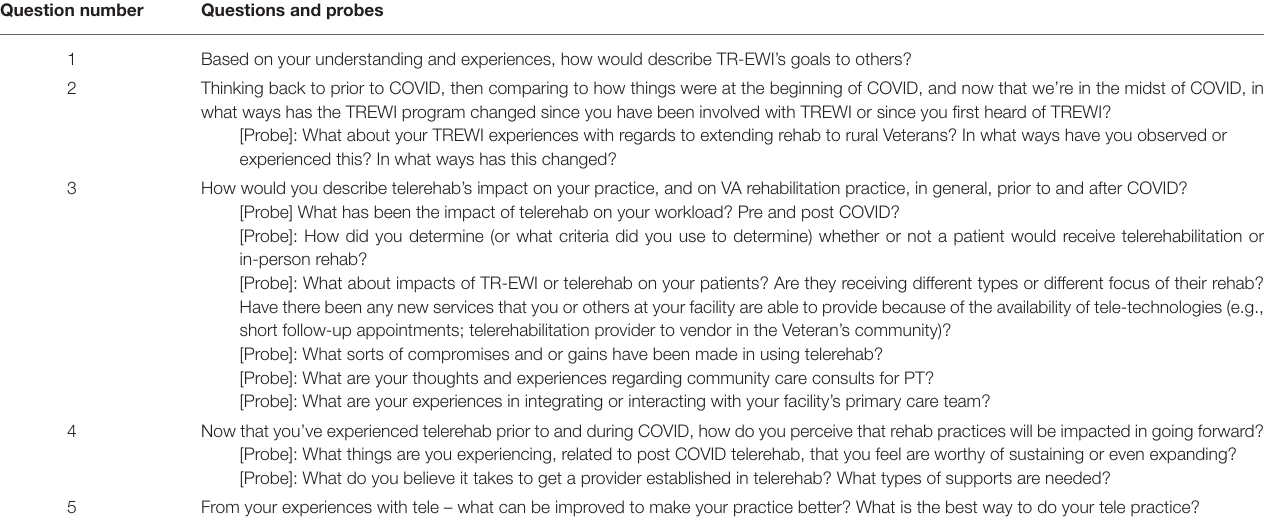
Question number Questions and